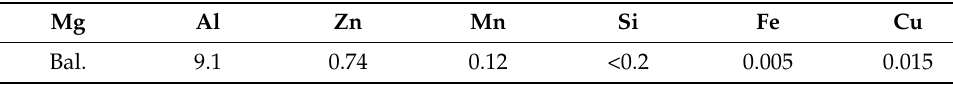
Table 1. Composition of Mg alloy (wt%).